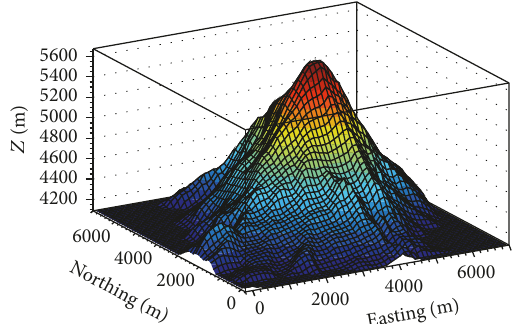
Figure 3: Topography of the Pico de Orizaba volcano, located in the state of Puebla in Mexico. The origin of the coordinate system is centered at the location of the HAWC array.